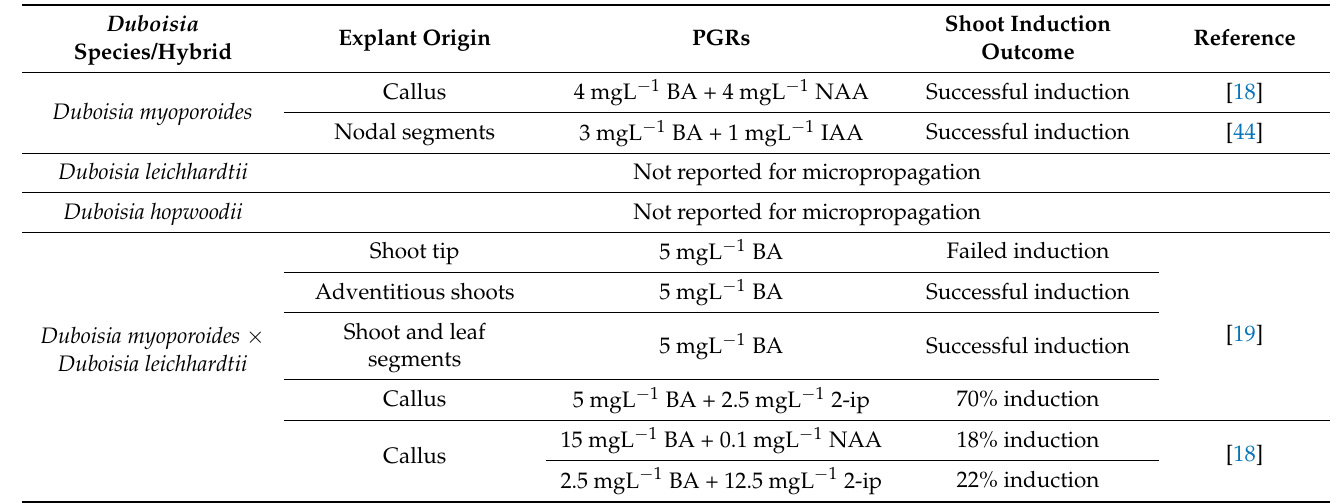
Table 3. Summary of PGRs used for shoot induction in Duboisia